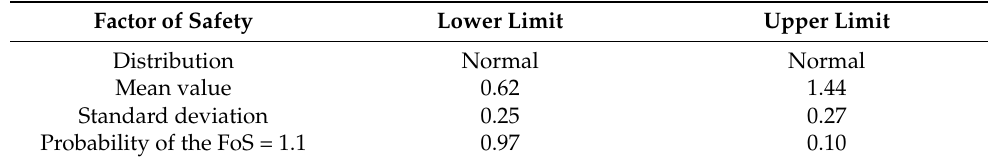
Table 4. The matching parameters.